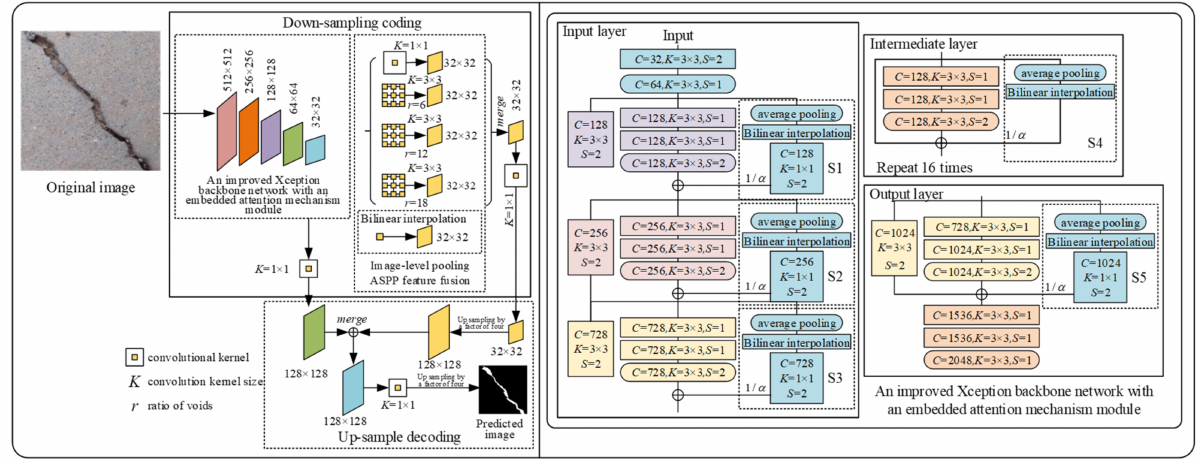
Figure 2. The flowchart of the improved